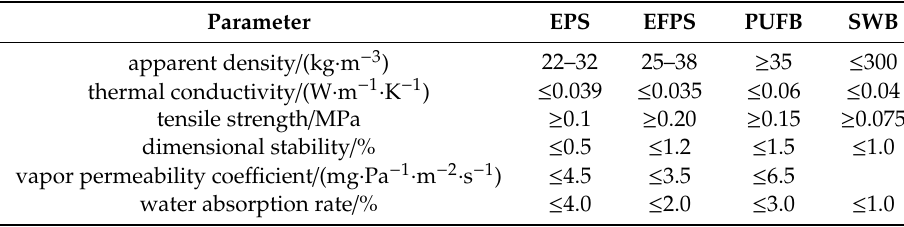
Table 5. Thermal properties of heat insulating